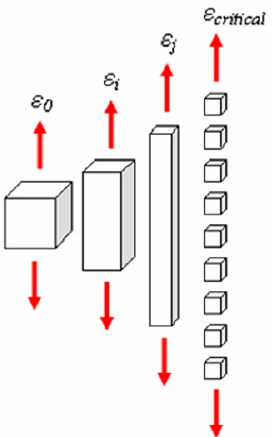
Figure 6. Schematic of critical strain, which controls the GDRX phenomenon in simulation.